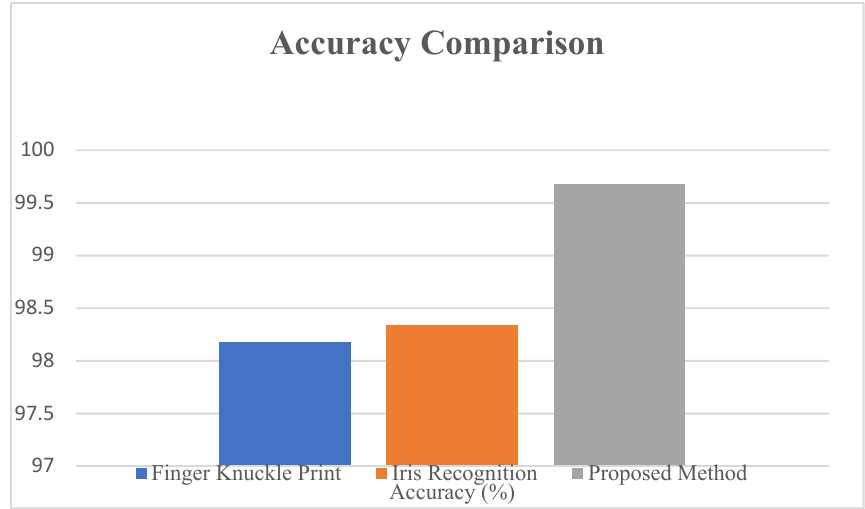
Figure 13. Accuracy comparison of FKP, iris, and proposed method.